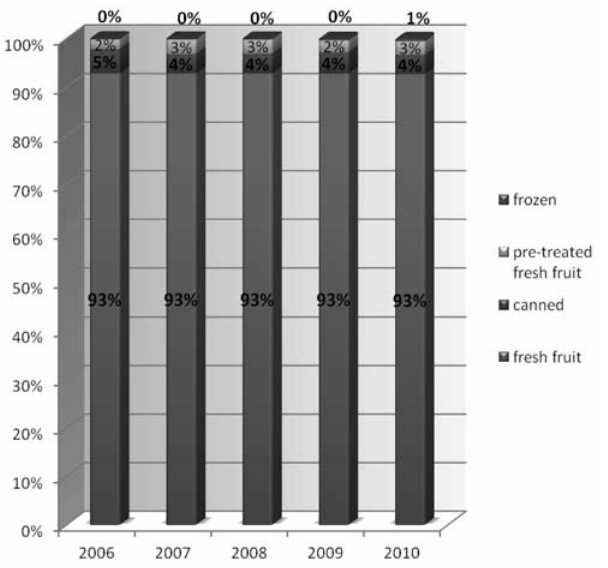
Figure 6. Supermarket Sales fruit (value) Source: PT / Nielsen